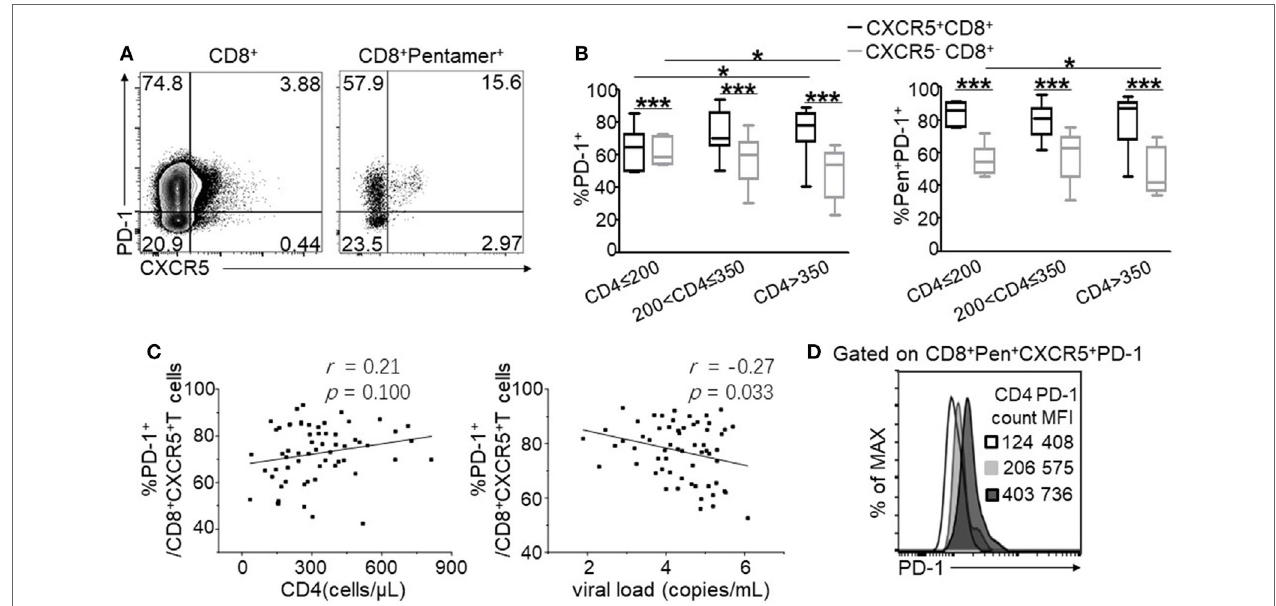
FigUre 3 | Programmed cell death 1 (PD-1) is highly expressed on CXCR5 + CD8 + T cells and negatively associated with HIV disease progression. (a) Representative flow cytometric data of PD-1 and CXCR5 staining gated on total CD8 + T cells and Pentamer + CD8 + T cells, respectively, from the peripheral blood. (B) Statistical analysis of PD-1 expression on CXCR5 + and CXCR5 − CD8 + T cells in three groups categorized by CD4 + T cell counts. (c) Correlation between the percentage of CD3 + CD8 + CXCR5 + PD-1 + T cells and CD4 + T cell counts (left, p = 0.100) or viral load (right, p = 0.033). (D) Representative data of PD-1 mean fluorescence intensity (MFI) on Pentamer + CXCR5 + CD8 + T cells. The data represent three independent experiments with similar results ( n > 5 for each